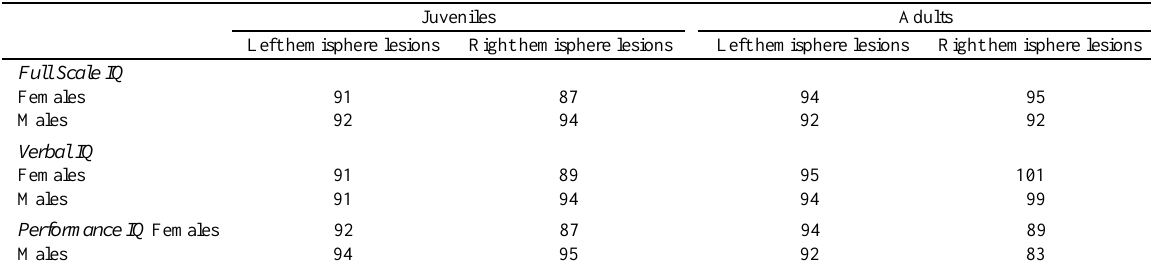
Table 5 Mean intelligence quotients (FSIQ, VIQ, PIQ) as a function of age-group ( ± 18), hemisphere lesioned and sex N = 544 ) Juveniles Adults Right hemisphere lesions Left hemisphere lesions Right hemisphere